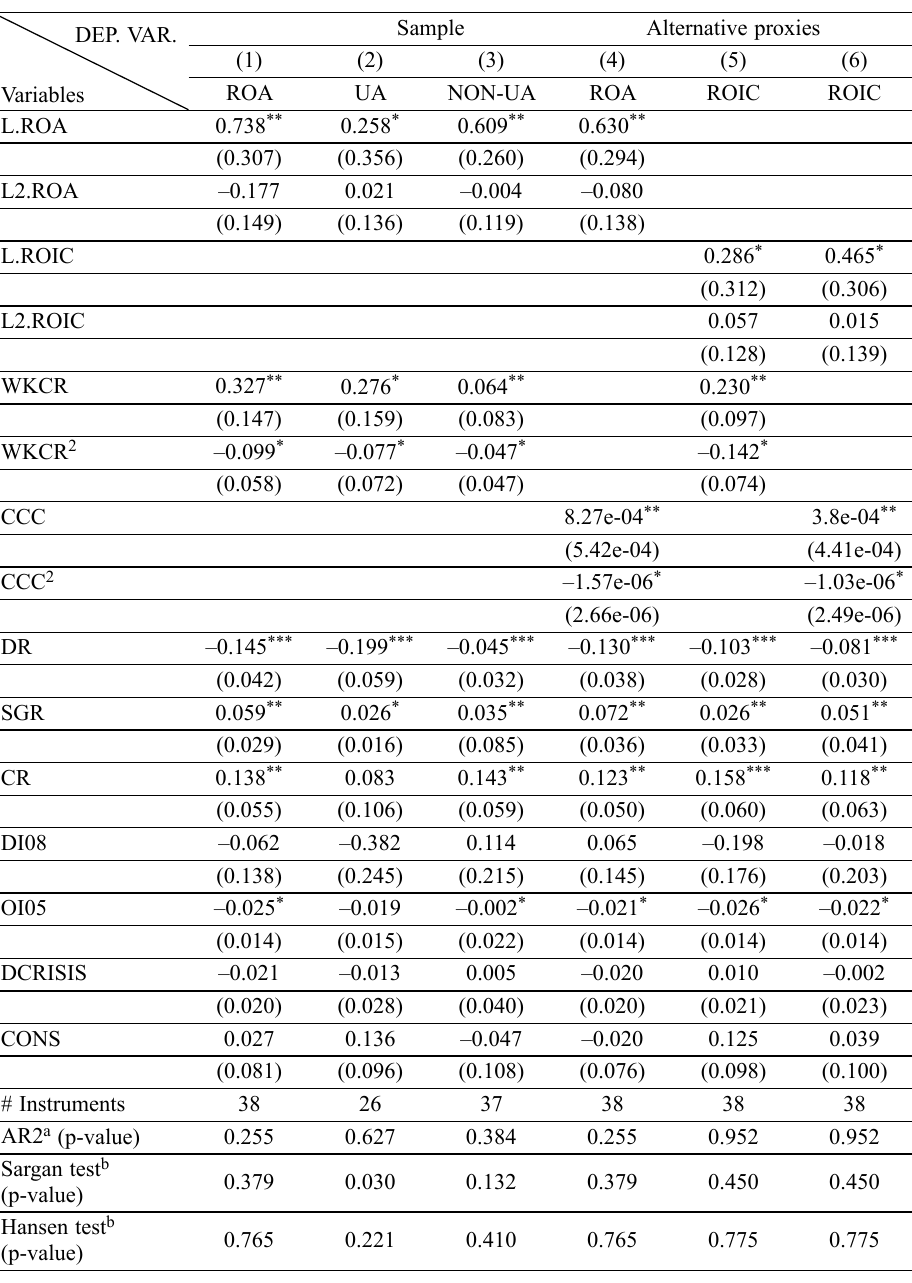
Table 4. Robustness check